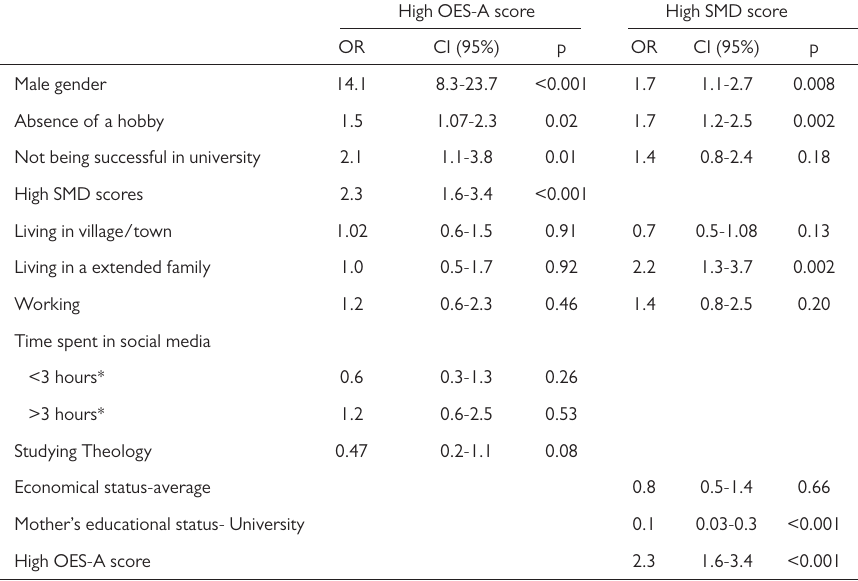
Table 3. Multivariate analysis of factors associated with high OES-A and SMD